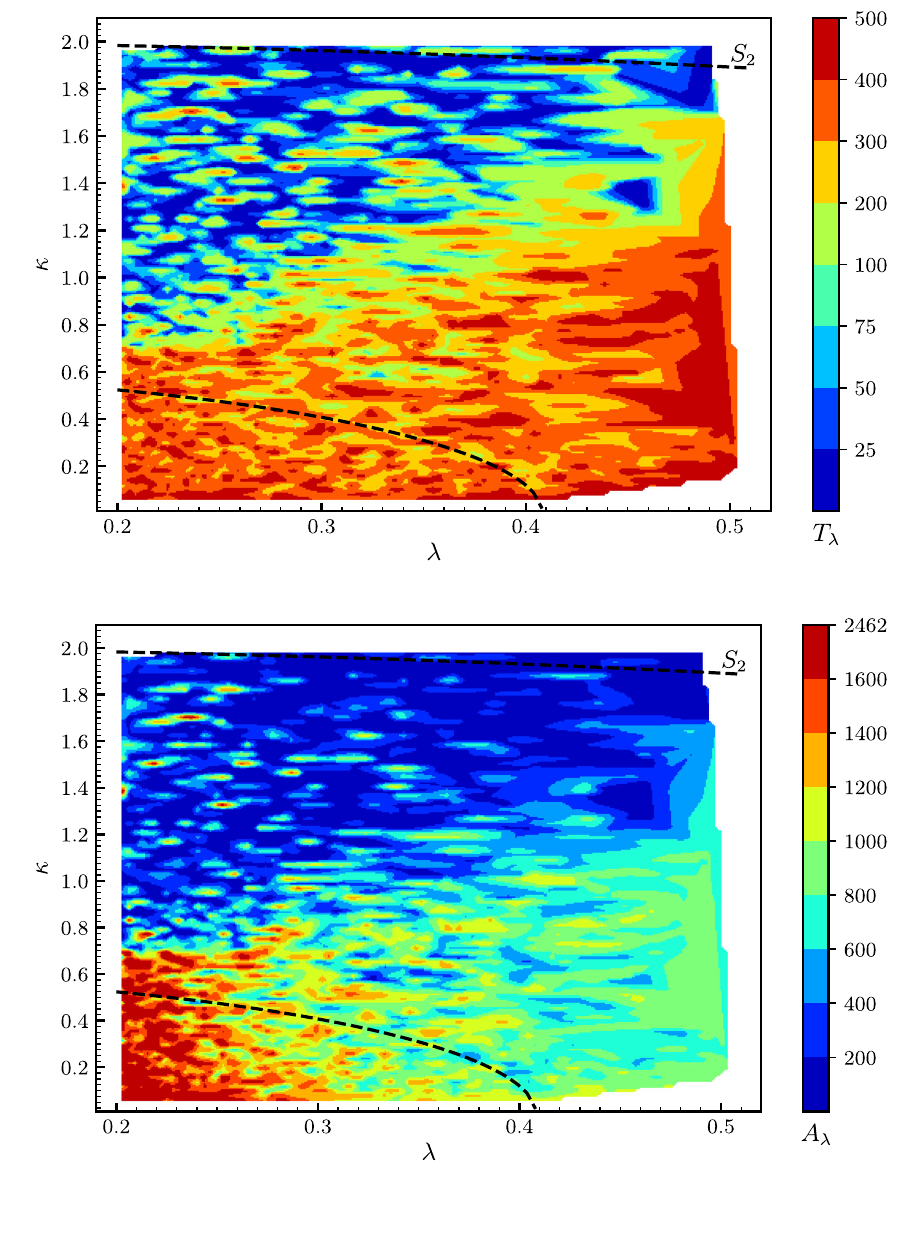
Fig. 26 The same as in Fig. 24, but the colours indicate different low-energy values of the trilinear soft terms T λ